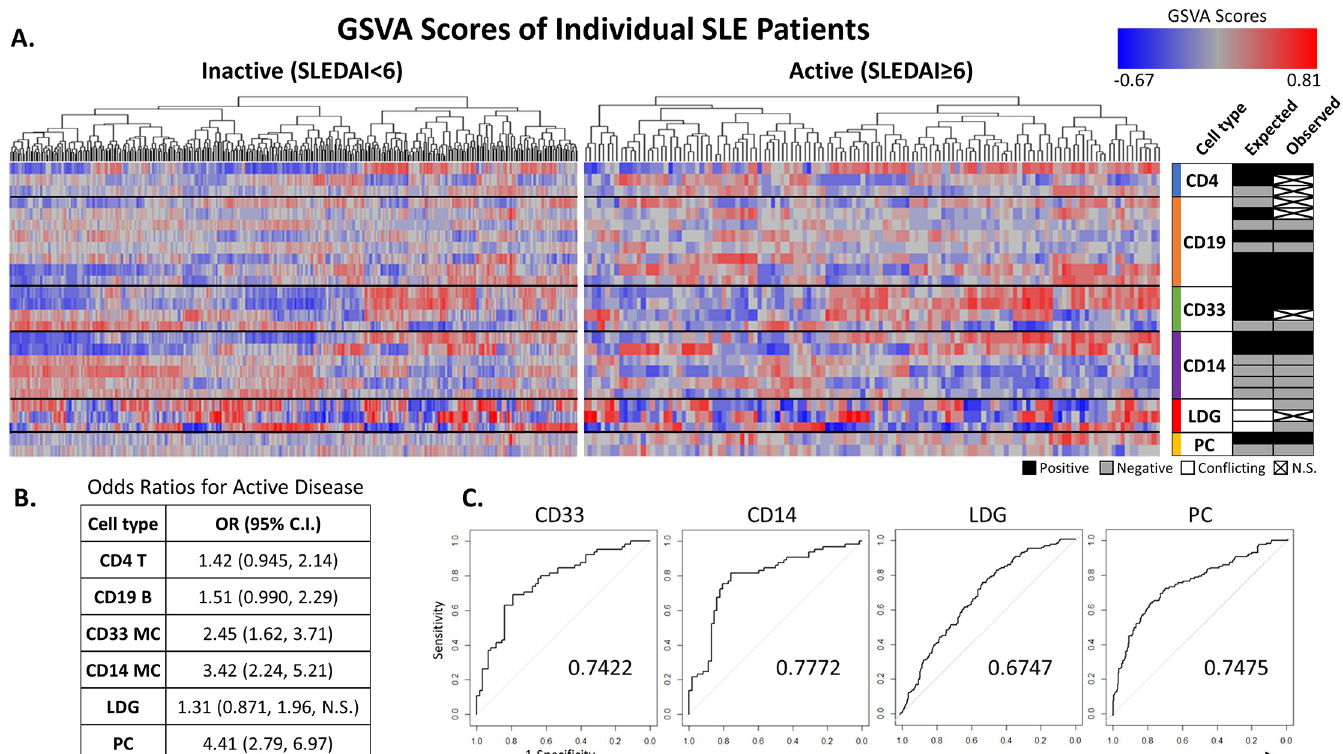
Fig 7. Cellular gene signature modules provide basis for machine learning predictions of SLE activity. (A) GSVA was utilized to generate scores to assess enrichment of WGCNA lymphocyte subset gene modules correlated with disease activity in WB or PBMC samples separated into inactive or active SLE patients. Results are shown following unsupervised hierarchical clustering. The expected and observed correlations to disease states of each module and the cell type of their origin are shown on the right (black: positive correlation; gray: negative correlation; white: unknown correlation; x: no significant correlation). (B) Odds ratios (OR) with 95% confidence intervals (CI) were calculated from the GSVA data to determine the strength of association of each cellular module with active disease. (C) ROC curves displaying representative results of disease activity prediction by the generalized linear model algorithm for modules from an individual cell type. Area under the curve is shown on each